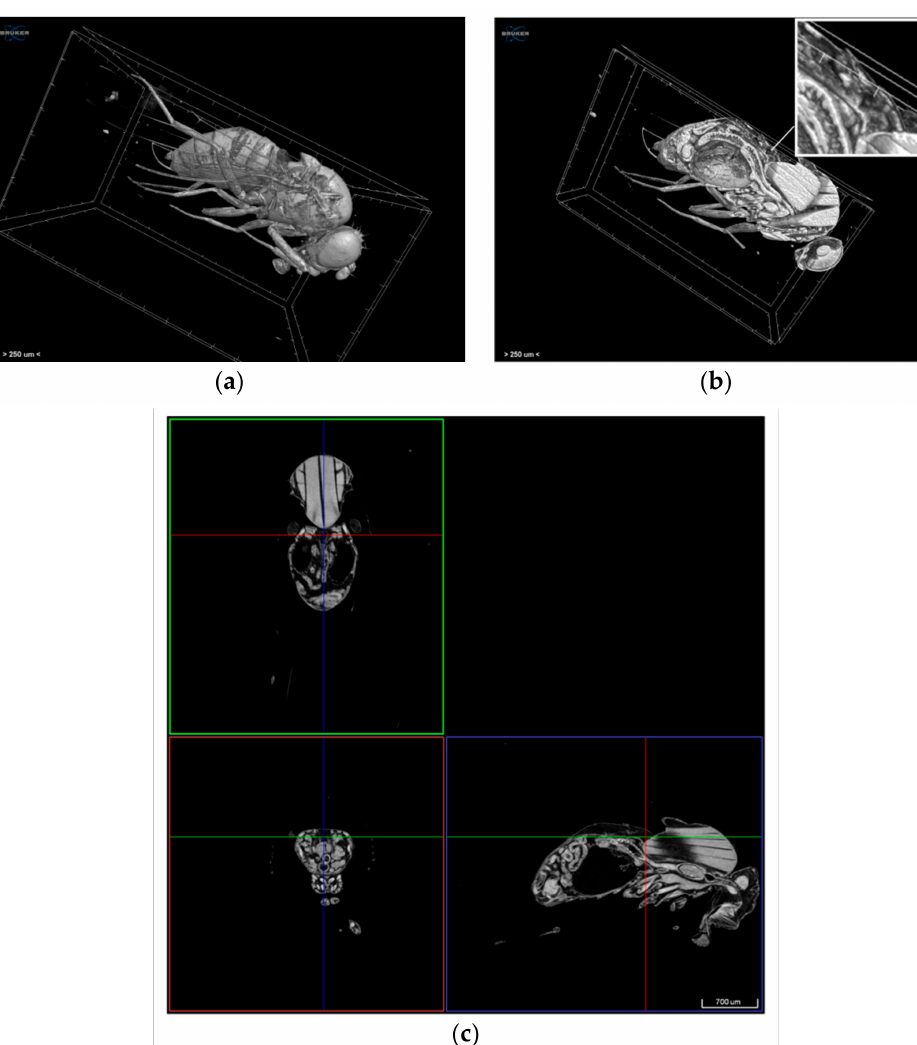
Figure 12. Volume rendering of ( a ) the whole specimen and ( b ) the virtually dissected specimen and ( c ) transaxial, sagittal, and coronal images of the Drosophila melanogaster acquired through the Skyscan 1172 micro-CT scanner. The white arrow and the cross-point of the coloured lines indicate the heart